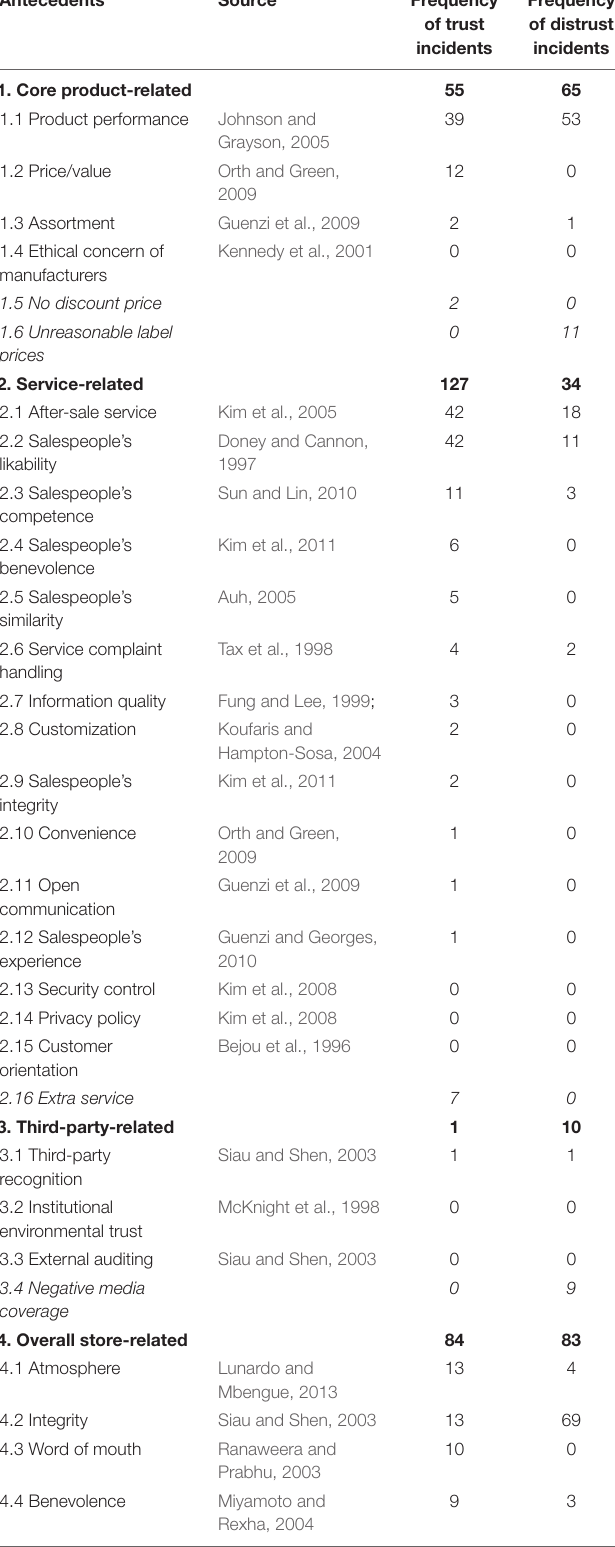
TABLE 1 | Coding frame and CIT results on antecedents of trust.